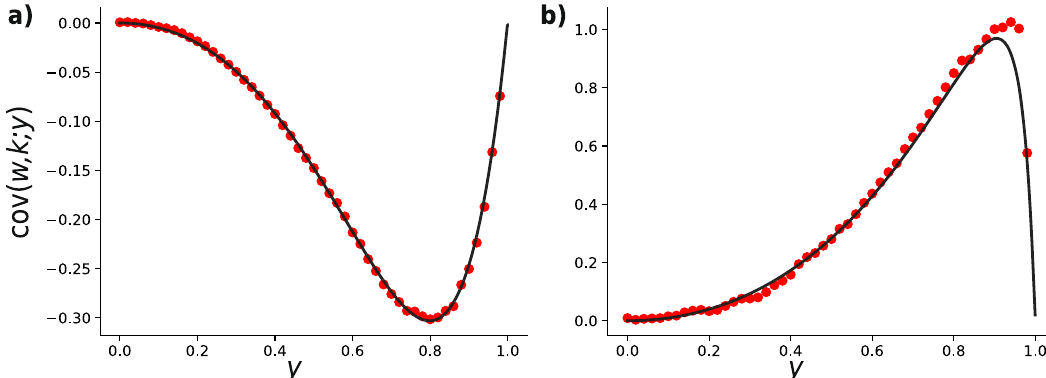
Fig. 6 Weight-degree covariance as a function of threshold y for a single instance of the damage – response process. The initial con fi gurations are given by: a a N = 25 × 10 3 nodes random regular graph with uniform weight distribution and b a N = 25 × 10 3 nodes scale-free network with exponent γ = 2.5, with uniform weight distribution (right panel). In both plots red markers represent the results from a single stochastic simulation, while continuous black lines show the analytical values from the theory. As we can see in the regular graph case the covariance is always negative, while the opposite happens in the scale-free network